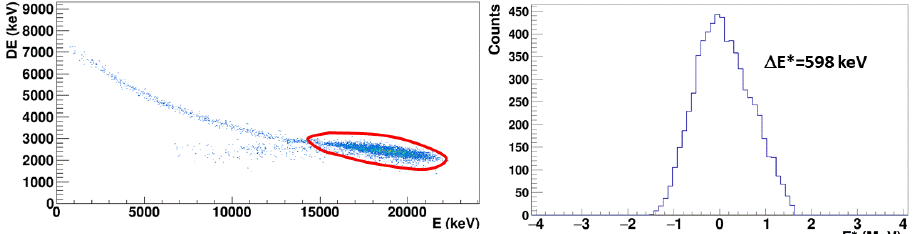
Fig. 3. (Left) Preliminary results of the energy loss versus residual energy for scattered protons detected at 64.5°. The red contour selects the elastically scattered protons. (Right) Preliminary results of the excitation energy of 208 Pb for the selected protons. The standard deviation of the peak is indicated.